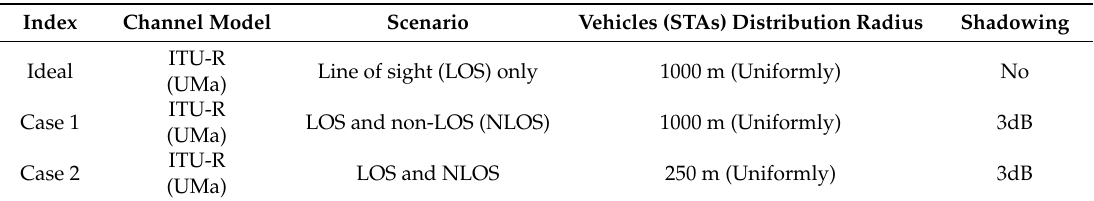
Table 2. Channel model parameters for simulation.